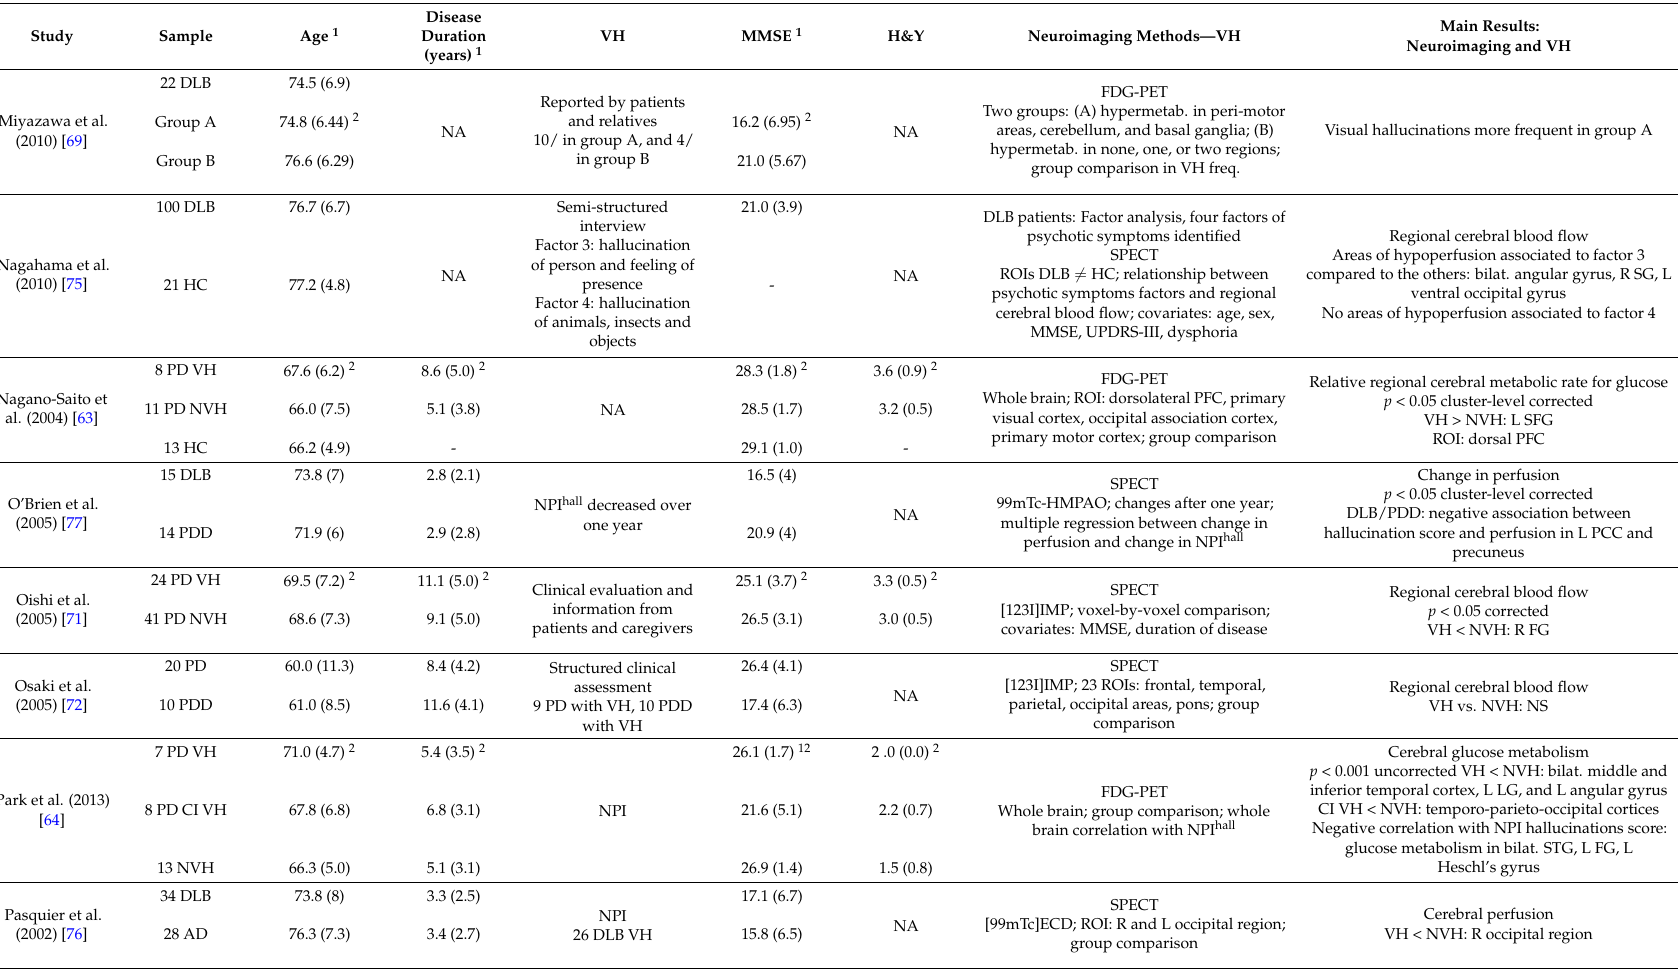
Main Results: Neuroimaging and VH